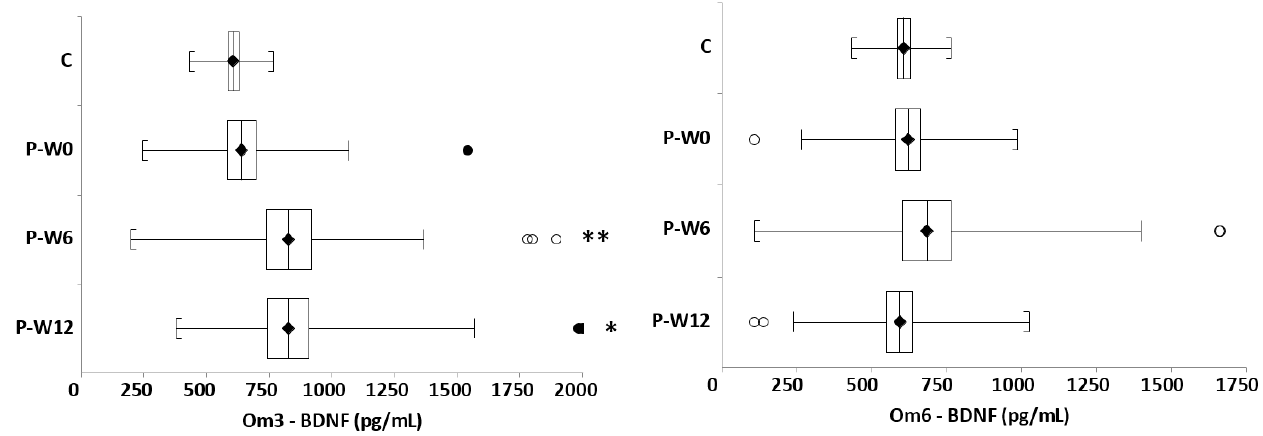
Figure 3. The levels of BDNF in healthy controls and in patients with depressive disorder, during the intervention. C = controls, P = patients, Om3 = omega-3 patient intervention group, Om6 = omega-6 patient intervention group, BDNF = brain-derived neurotrophic factor, W = week of the intervention; • outer fence for outlier, ° inner fence for outlier. * p < 0.05 with respect to W0, ** p < 0.01 with respect to W0.